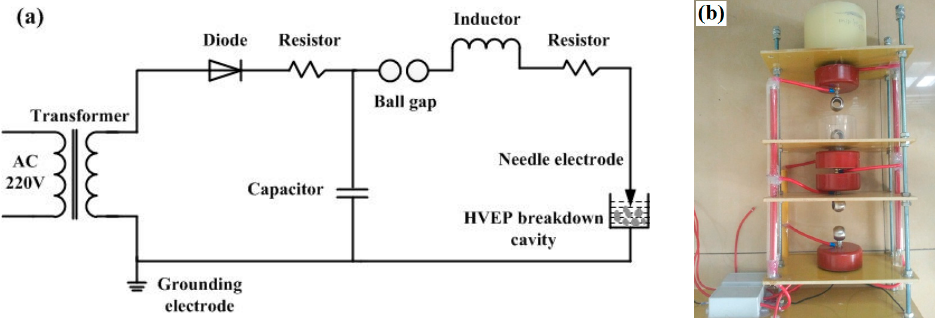
Figure 3. Photomicrographs of studied magnetite iron ore ( a ) taken under reflected light and ( b ) taken under polarized light.